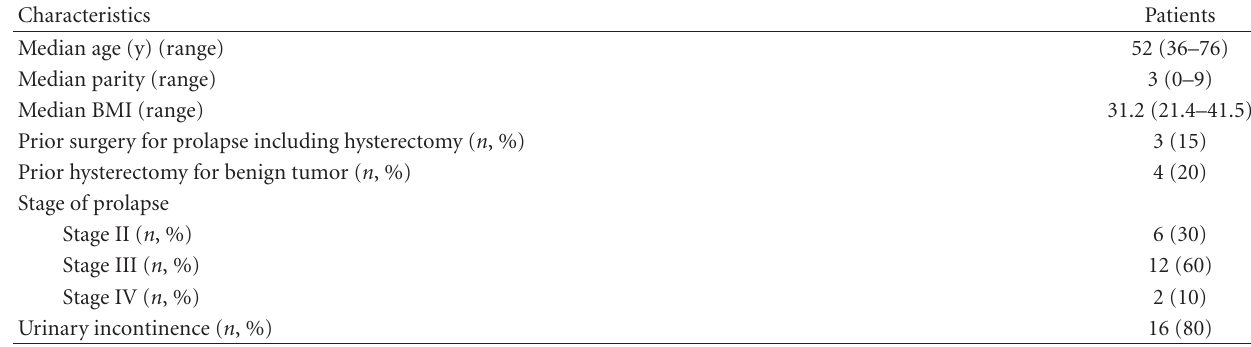
Table 1: Demographic and clinical characteristics of the